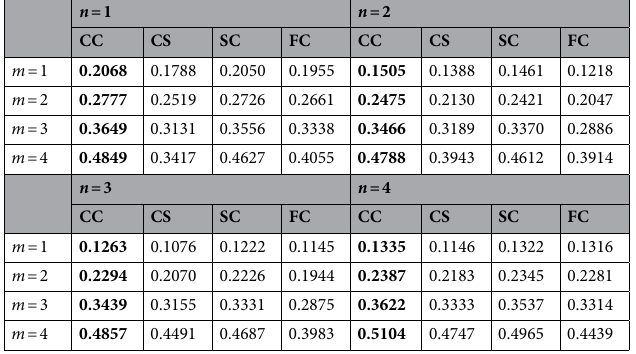
Table 4. Dependency of the natural frequencies on the boundary conditions. Significance values are given in bold.